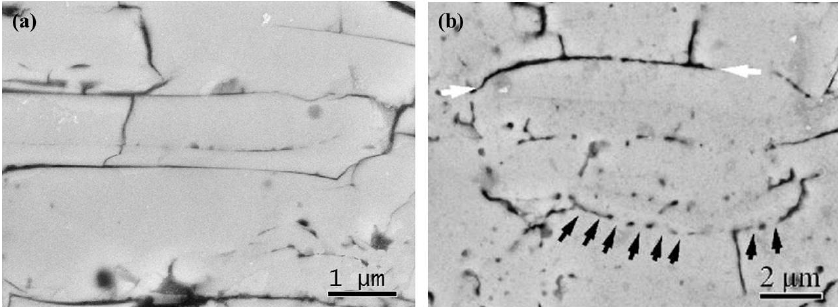
Fig. 31 Changes in 2D pores during thermal exposure at 1300 ℃ : (a) 0 h and (b) 1 h. Reproduced with permission from Ref. [164], © ASM International 2015.